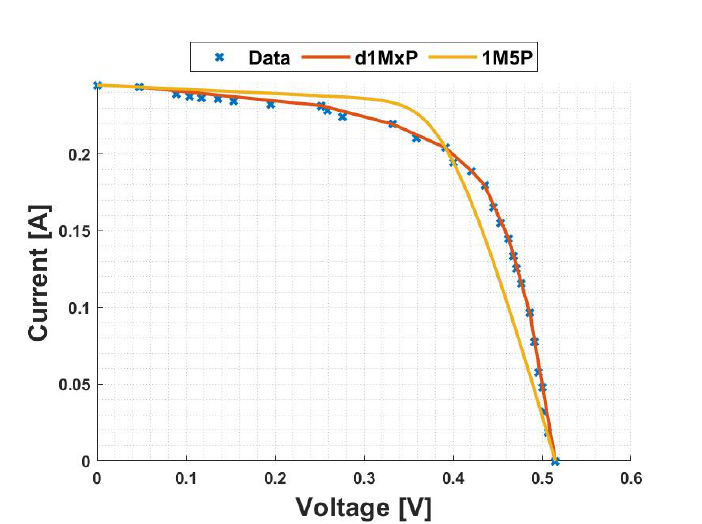
Figure 12. I-V curves using the 1M5P model and the proposed model, at T = 60 ◦ C.